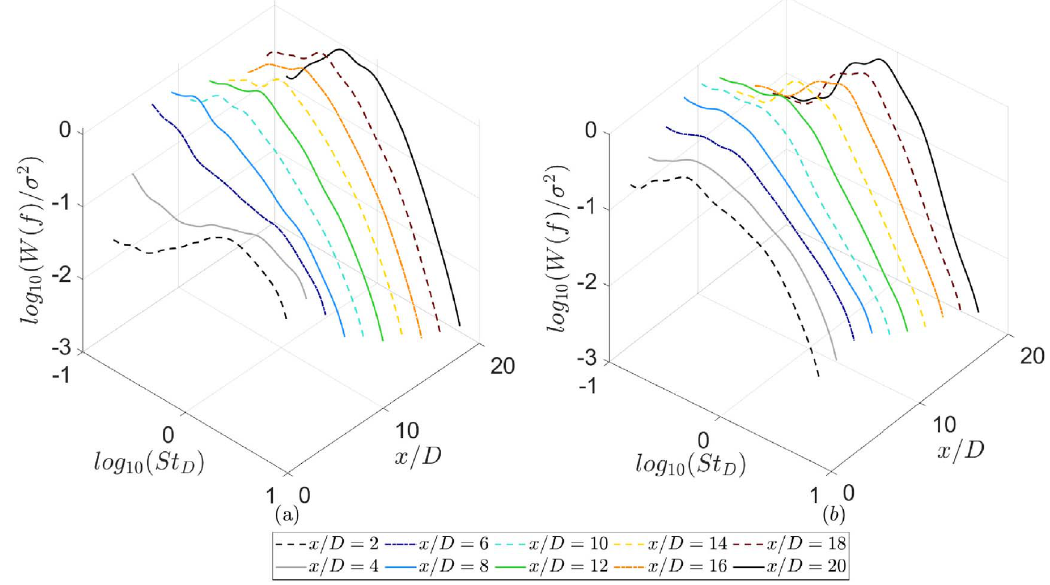
Figure 7. Wavelet spectra taken at r / D = 3 for different x / D and different boundary layer thickness d . (a) d / D = 0.0025 and (b) d / D =